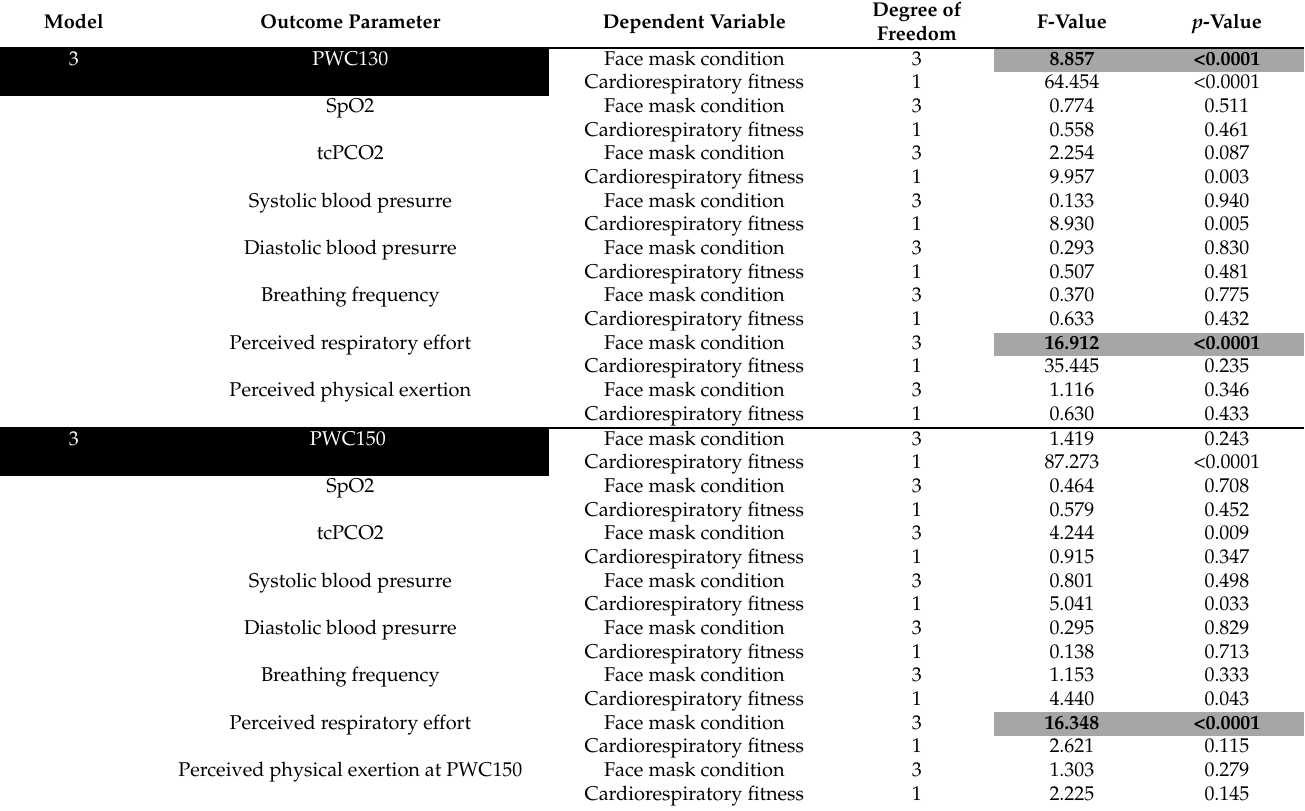
Table A6. Comparison of all face masks including face mask condition and cardiorespiratory fitness (maximum physical working performance of an initial bicycle ergometer test)—linear mixed model 3.